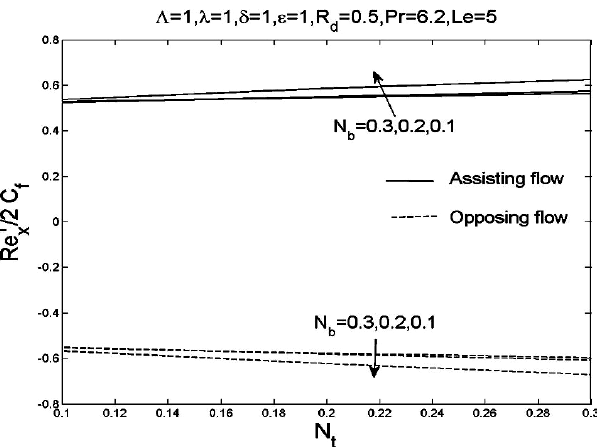
Fig. 27. The effect of the thermophoresis parameter Nt and Nb the Brownian motion parameter on the skin friction